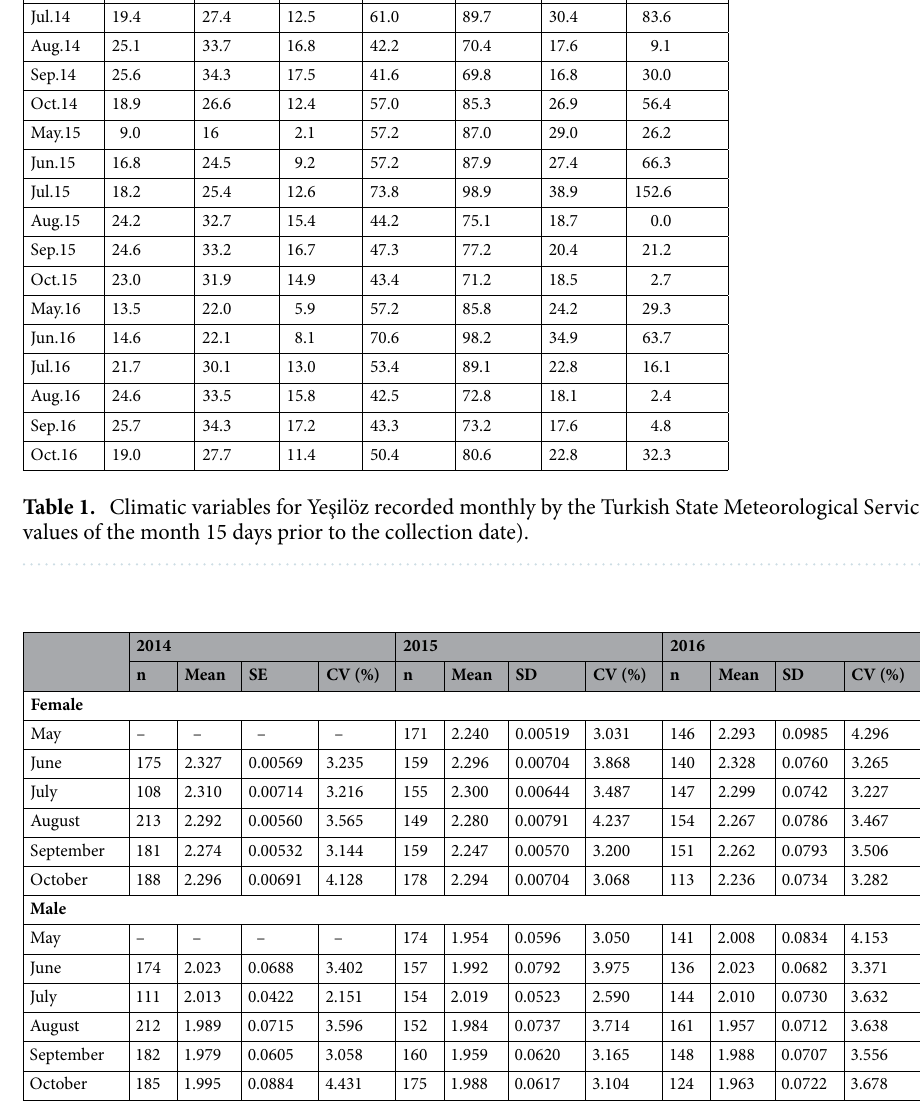
Table 2. Mean values and coefficients of variation (CV’s) for mean wing CS of inbred lines collected from different moths across three